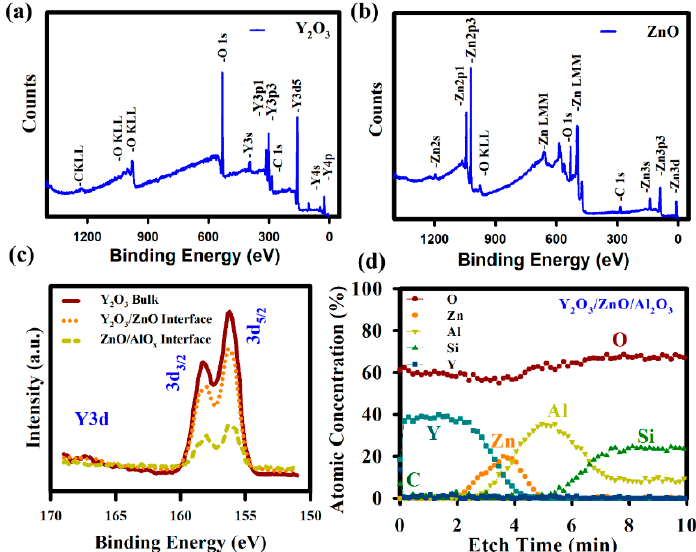
Figure 2. X-ray photoelectron spectroscopy (XPS) survey spectra of ( a ) Y 2 O 3 and ( b ) ZnO films. ( c ) The Y3d peaks at different depths of Y 2 O 3 /ZnO/Al 2 O 3 film. Y could be found at the bottom interface (ZnO/Al 2 O 3 ). ( d ) XPS depth profiles of O, Y, C, Zn, Al, and Si of Y 2 O 3 /ZnO/Al 2 O 3 film.